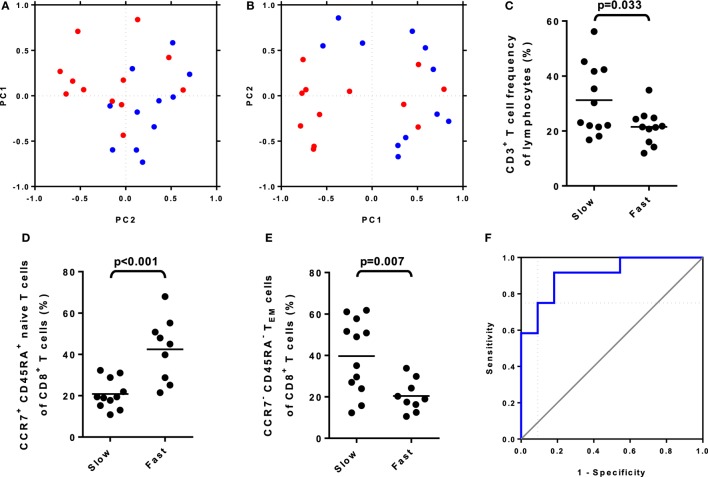
Statistical analyses of flow cytometry dataset. (A) The first two principal components (PC1, PC2) of entire dataset of baseline standardized leukocyte frequencies partly distinguished fast (red) and slow (blue) responders. (B) After filtering the baseline dataset for leukocyte populations whose frequencies were significantly influenced by direct-acting antiviral treatments, the first two principal components of standardized leukocyte frequencies separated fast (red) and slow (blue) responders. (C) Comparison of baseline CD3+ T cell frequency between fast and slow responders. (D) Comparison of baseline naïve CD8+ T cell frequency between fast and slow responders. (E) Comparison of baseline CD8+ TEM cell frequency between fast and slow responders. (F) Baseline CD3+ T cell frequency and baseline naïve CD8+ T cell frequency were entered as independent variables in a binary logistic regression model. A cutoff probability of 0.66 for scoring fast and slow responders was determined using receiver operator characteristic curve analysis, which gave a test sensitivity of 75.0% and specificity of 91.0%.